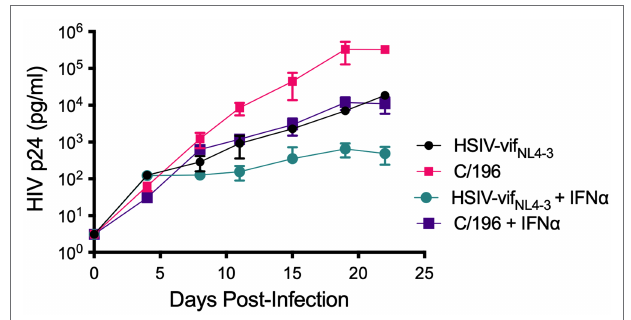
FIGURE 2 | Replication kinetics of biological isolates of HSIV-vif NL4-3 (C/196 and C/200). PTM CD4 + T cells were infected in duplicate at a MOI of 0.01 with the parental HSIV-vif NL4-3 or variant isolates C/196 in the presence or absence of IFN α (200 U/ml) in the culture media. Virus supernatants were collected every 3–4 dpi and p24 was quantified by ELISA.